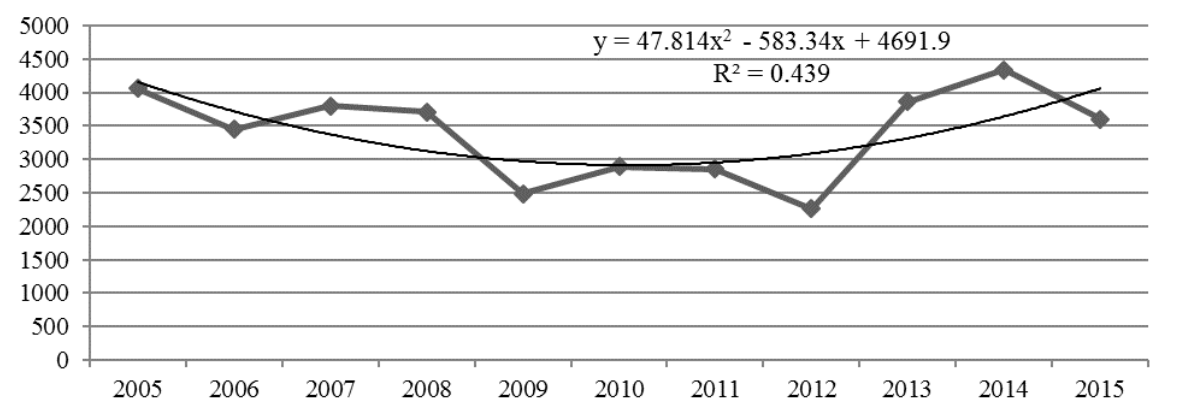
Fig. 4. Determination of the type of growth curve for the indicator of gross insurance premiums for financial risk insurance in 2005 – 2015